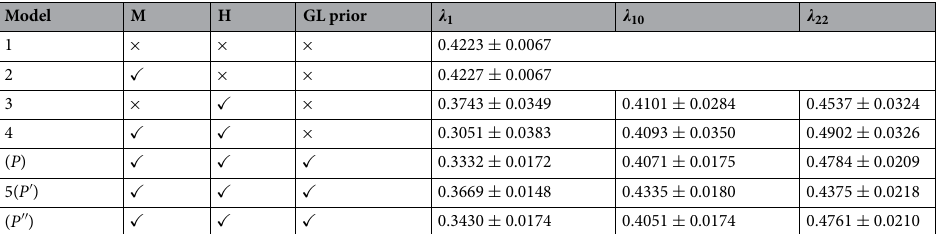
Table 5. Estimated (cid:31) i with standard deviation using Models 1–5 for simulated data with thirty provinces. The ground truth is (cid:31) 1 = 0.307 (in D 1 ), (cid:31) 10 = 0.416 (in D 2 ), (cid:31) 22 = 0.493 (in D 3 ) as listed in Sect. C of Supplementary Information. Remarks for Columns 1–4 and estimates of (cid:31) k ’s are the same as those in Table 3. In addition, for inference of parameters using Model 5, µ ∗ = 10 1.8 , at which the averaged validation errors over 100 replicas (computed with partition P ) are minimized as shown in Fig. 7 and Supplementary Fig. S4. The partitions of Model 5 are P , P ′ , and P ′′ respectively. P is the ground truth underlying graph structure, and P ′ and P ′′ are mismatched partitions introduced in “Models to compare”.